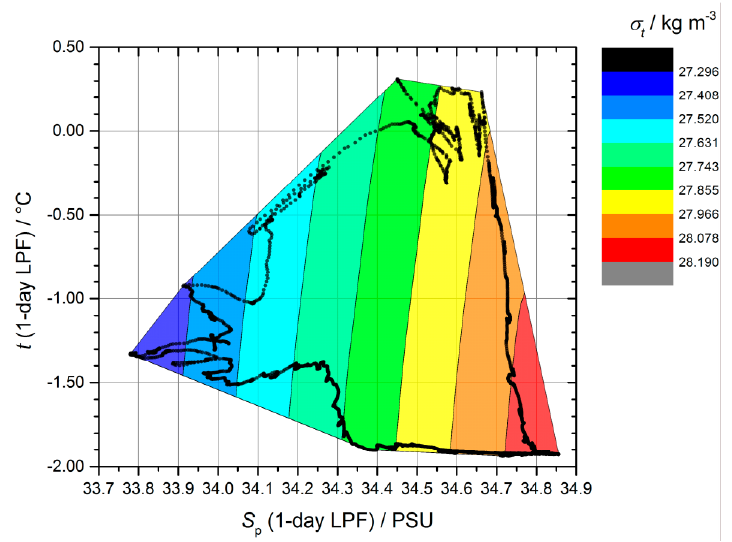
Figure 6. t – S P – σ t plot: daily mean (low-pass filter (LPF) with a moving window of 24 h) values for the period November 2018–November 2019 in Terra Nova Bay. Annual SI C and Chl -a trends from satellite data were compared with experimental values of DO and E V (Figure 7). The lowest SIC values (sea ice area fraction equal to 0) were recorded in December 2018 and February 2019, whereas the maximum peaks of the sea ice area fraction (greater than 0.8) were recorded in July and August 2019 (Figure 7a). Data on Chl -a (Figure 7b) revealed that the maximum mass concentration value, 0.2–1.1 mg m − 3 , occurred from December 2019 to the first half of March 2019 and at the end of November 2019, in correspondence to the lowest sea ice area fractions. On comparing the trends of all these parameters, it was clear that DO fully phased with the algal bloom ( Chl -a trend) during the summer season (Figure 7c). DO was the parameter with a fast response time,